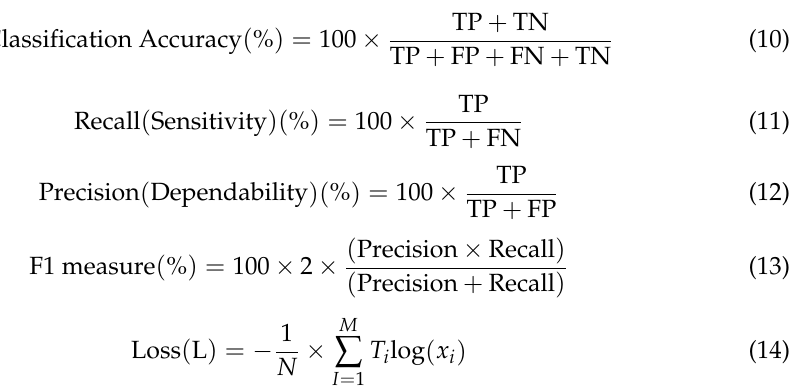
Table 4. For arcing and non-arcing cases, a confusion matrix.